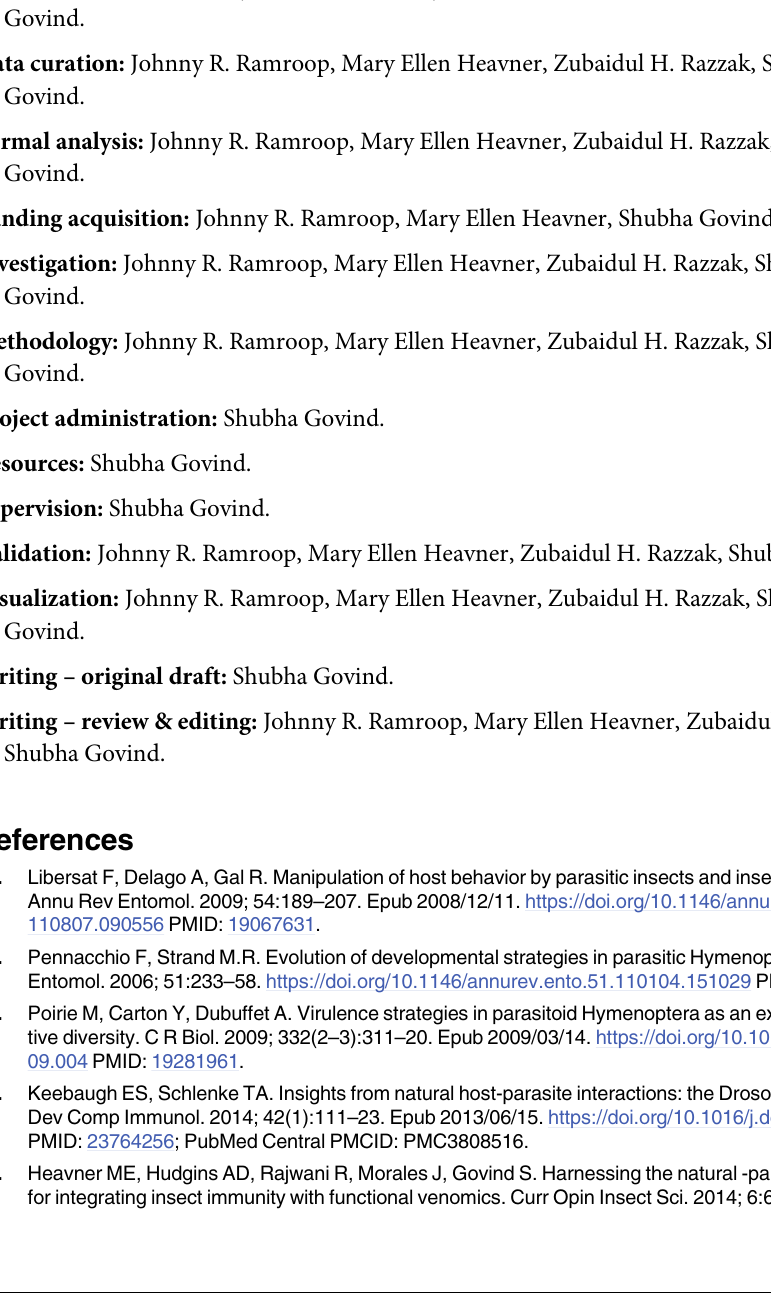
Rab5 KD animals varied with different GAL4 drivers. ( F ) Viability to adulthood was differen- tially affected. More than 100 animals were scored for each cross in panels ( E ) and ( F